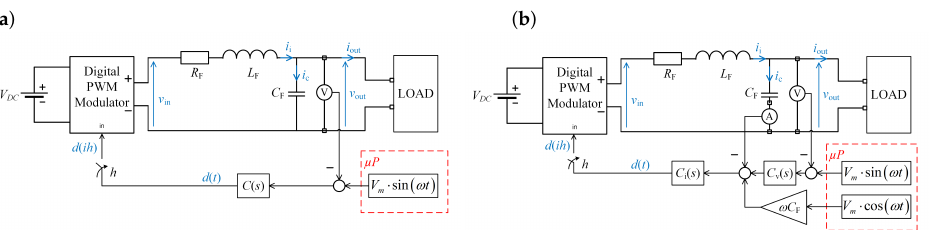
Figure 2. Schematic diagrams of digital control systems: ( a ) 1Ld-digital single loop, ( b ) 2Ld-digital double loop. Switches symbolize sampling performed by Analog-to-Digital-Converters (ADC).